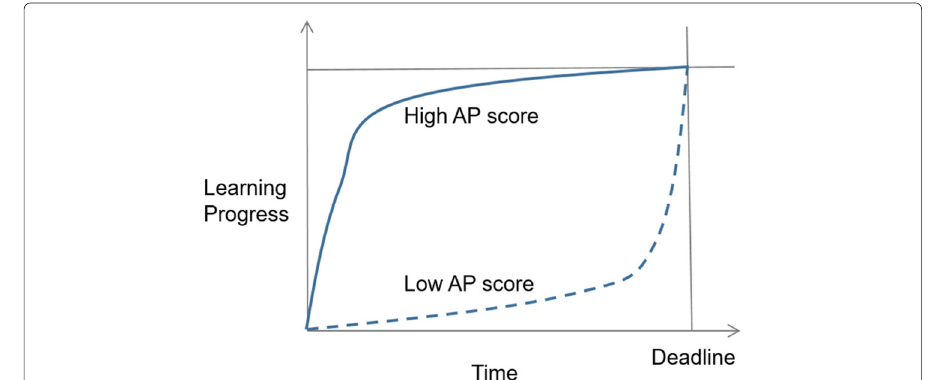
Fig. 2 An example of high and low anti-procrastination (AP)